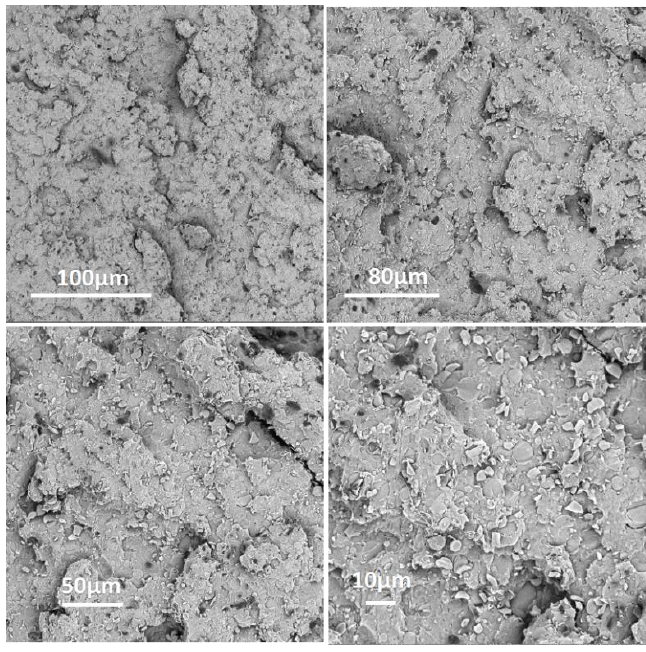
Figure 10. SEM micrograph of the cryo-fracture of the PLA/25% HABP-DOPO composite.